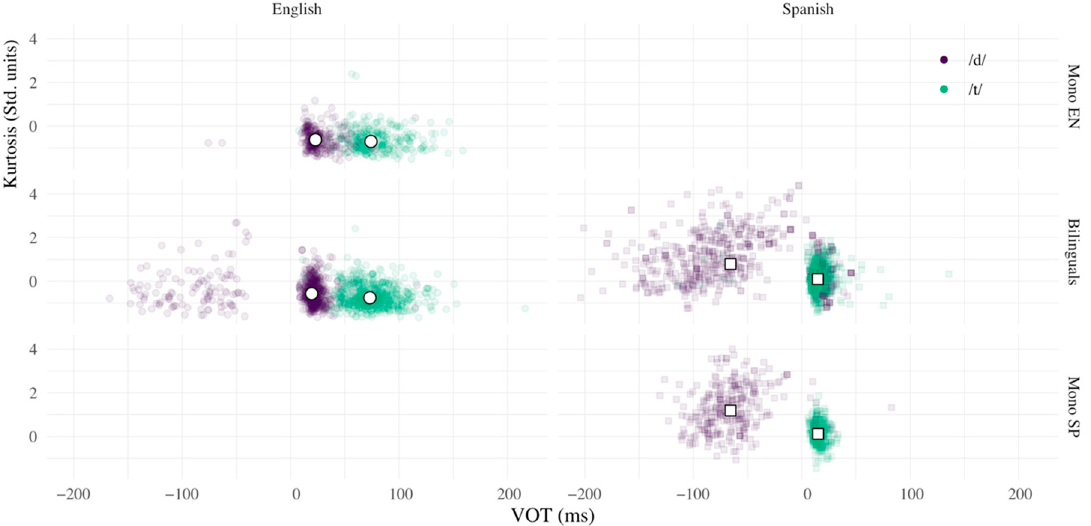
Figure 5. Voice-onset time (horizontal axis) and Kurtosis (vertical axis) as a function of speaker group and stop category. Colored points represent raw data. White points represent category medians.